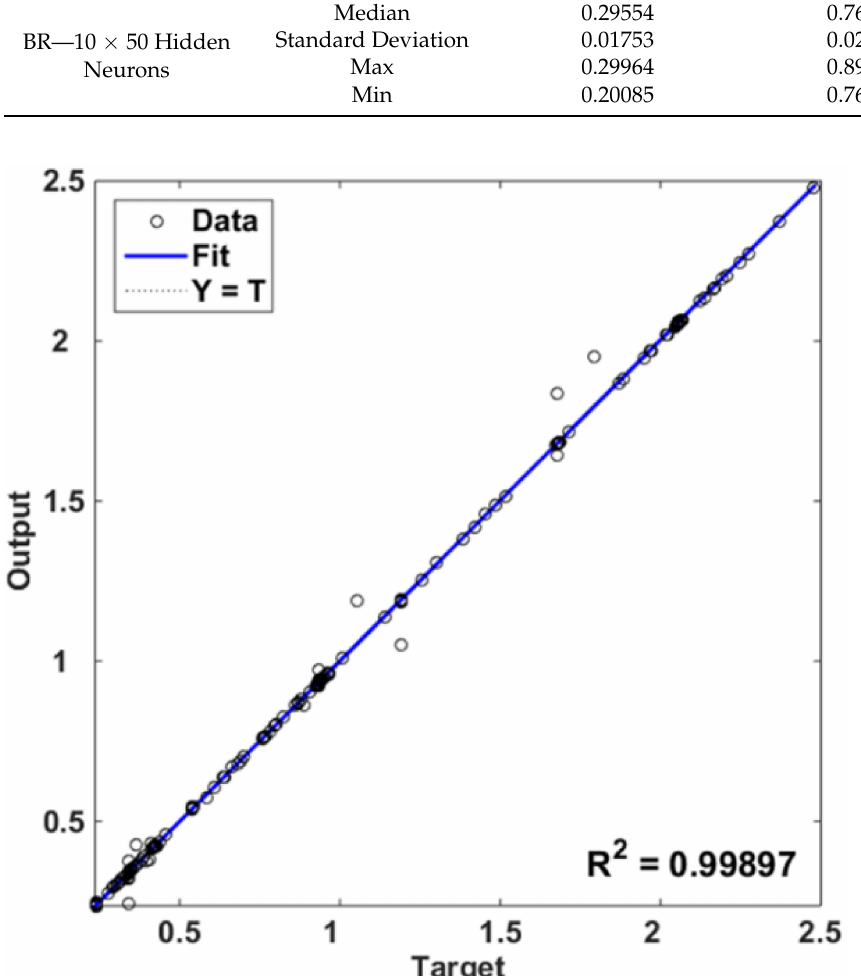
Figure 11. Regression plot of FFNN1 with BR and 50 hidden